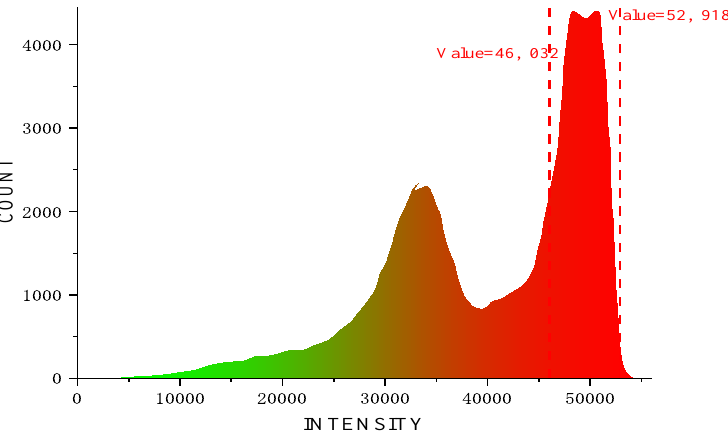
Figure 21. Selecting a range of intensity values of of the laser point clouds of Figure 20 for segmentation.